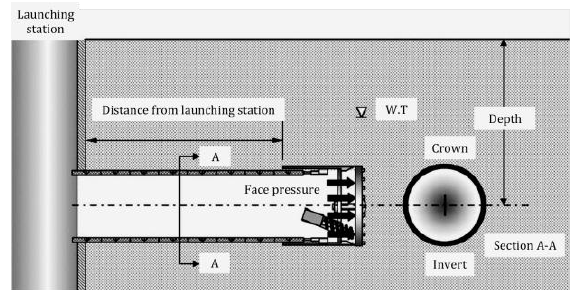
Figure 3. Geological and geometry parameters [15].